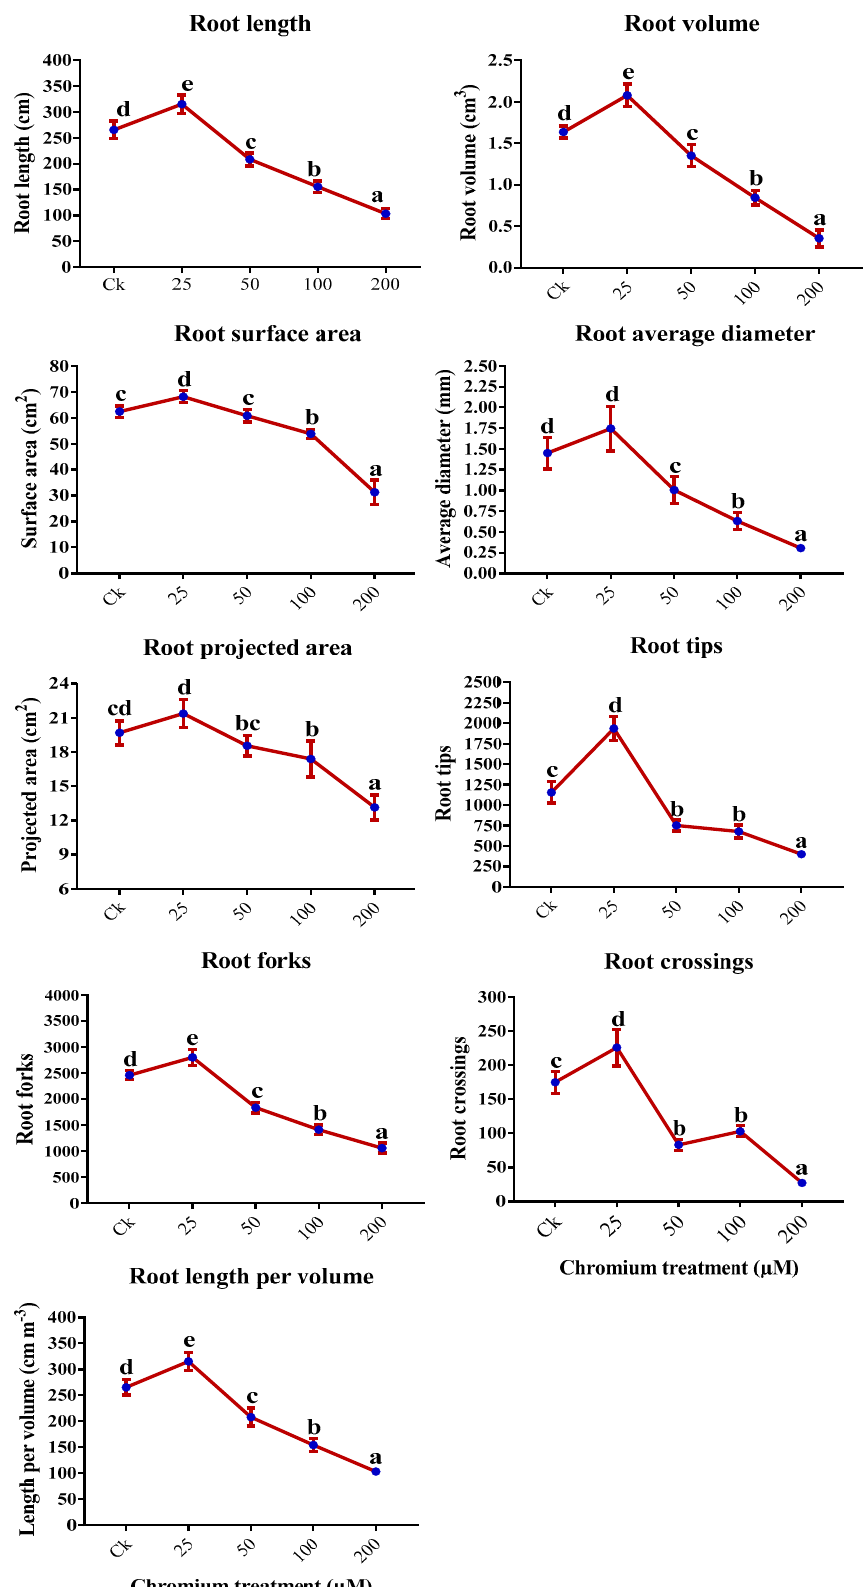
Figure 5. Impact of Cr on root morphological traits of sweet potato. Means followed by different letters indicate a significant difference ( p < 0.05) among the five treatments according to the Tuckey test. Error bars show mean ± SE.